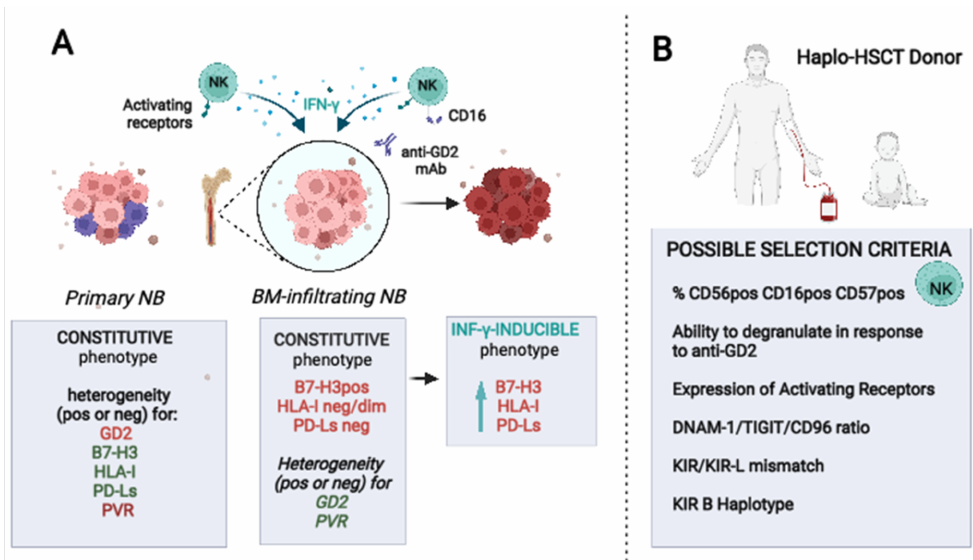
Figure 2. Constitutive and IFN- γ -induced immunophenotype of primary and BM-infiltrating NB cells. ( A ) Primary NB show intratumor molecular heterogeneity whereas BM-infiltrating NB cells have a more homogeneous B7-H3pos and the neg/low expression of HLA-I and PD-Ls. Inhibitory ligands are induced/upregulated by IFN- γ released upon NK cell activation by tumor ligands or the anti-GD2 mAb. ( B ) Possible features of the NK cell population to be considered for the selection of the best haplo-HSCT donor (in order of priority). Optimal selection criteria could improve the NK cell persistence and NK vs. NB cytotoxicity, both spontaneous and anti-GD2 mAb-mediated. Created with